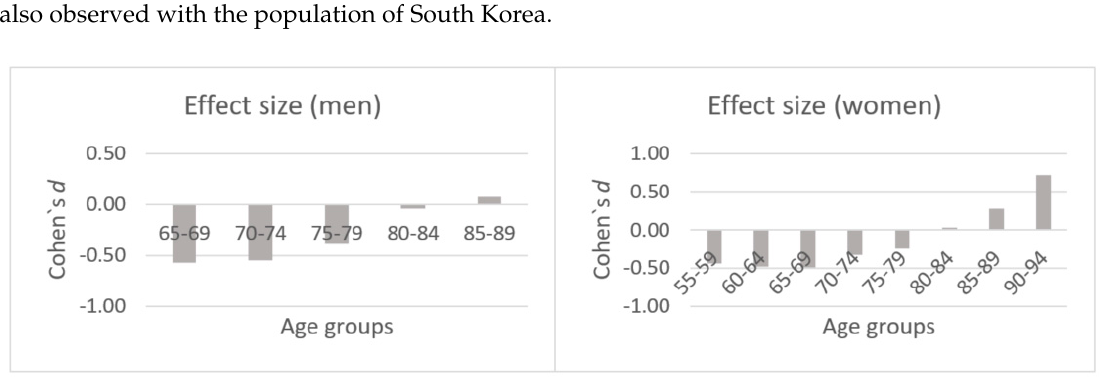
ff ect size by five-year age groups in our sample vs. the Great Britain Figure 3. Effect size by five-year age groups in our sample vs. the Great Britain population. Figure 3. E